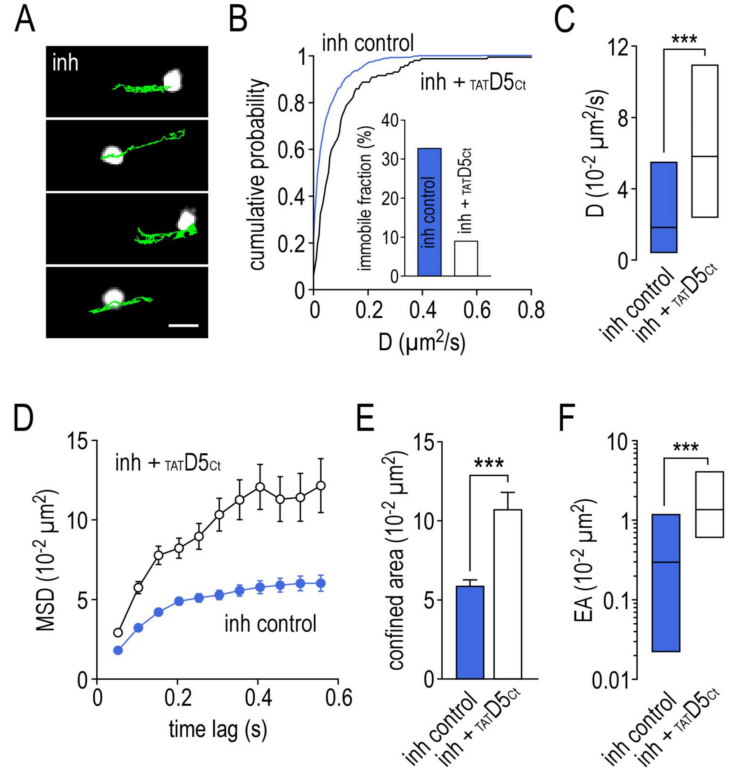
Figure 4. The disrupting peptide impairs the surface dynamic properties of GABA A receptors at inhibitory synapses. ( A ) Examples of trajectories of a single GABA A receptor–SEP–anti-GFP antibody–QD complex (500 frames, 50 ms acquisition) in the presence of the competing peptide (10 µ M) with identified inhibitory (inh) synaptic areas. Scale bar, 350 nm. ( B ) Cumulative probability diffusion coefficient of GABA A receptors at inhibitory synapses in control condition or in the presence of the disrupting peptide. The inset shows the immobile fraction (defined as D < 0.005 µ m 2 /s) in the inhibitory area in control condition and in the presence of the disrupting peptide. ( C ) Bar graphs illustrating the instantaneous diffusion coefficient (D, represented as median ± interquartile range 25–75%) in inhibitory area in control condition or in the presence of the disrupting peptide. ( D ) Comparison of GABA A receptors mean square displacements (MSD, represented as mean ± SEM) in inhibitory area in control condition or in the presence of the disrupting peptide. ( E ) Bar graphs illustrating the confined area (for the time period of 250–550 ms and represented as mean ± SEM) in inhibitory area in control condition or in the presence of the disrupting peptide. ( F ) Bar graphs illustrating the explored surface area (EA, represented as median ± interquartile range 25–75%) in inhibitory area in control condition or in the presence of the disrupting peptide. *** p < 0.001. Nonparametric Mann–Whitney